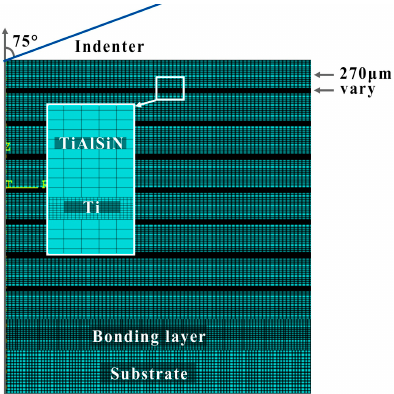
Figure 3. Finite element model geometry of TiAlSiN/Ti multilayer coatings. Table 1. Thickness of Ti interlayer and mechanical properties of all the samples.